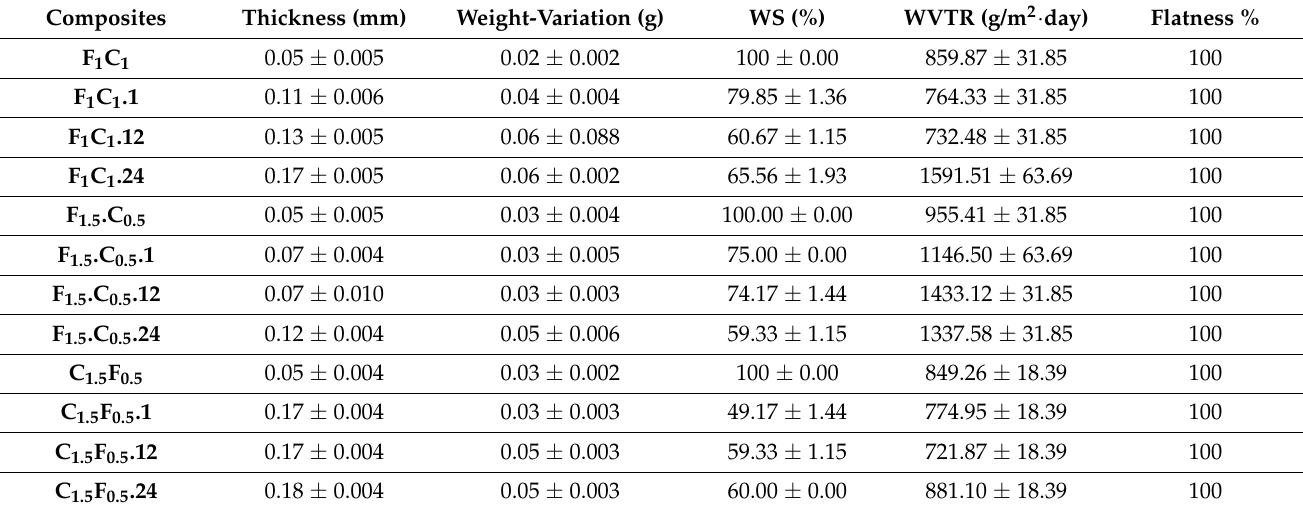
Table 2. Water solubility (WS), Water vapor transmission rate (WVTR), and Flatness